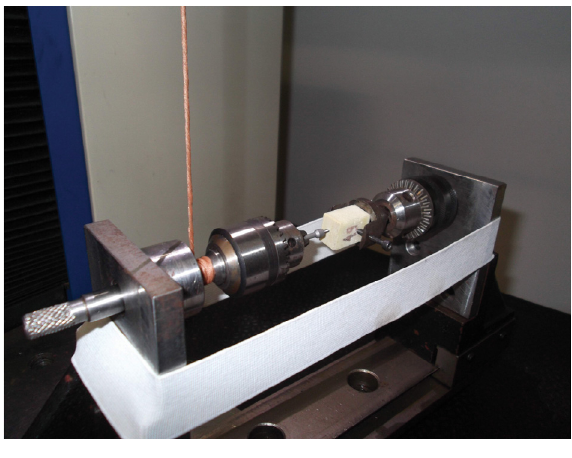
Figure 3. Photograph of the device used in the torsion me- chanical testing of MIs.